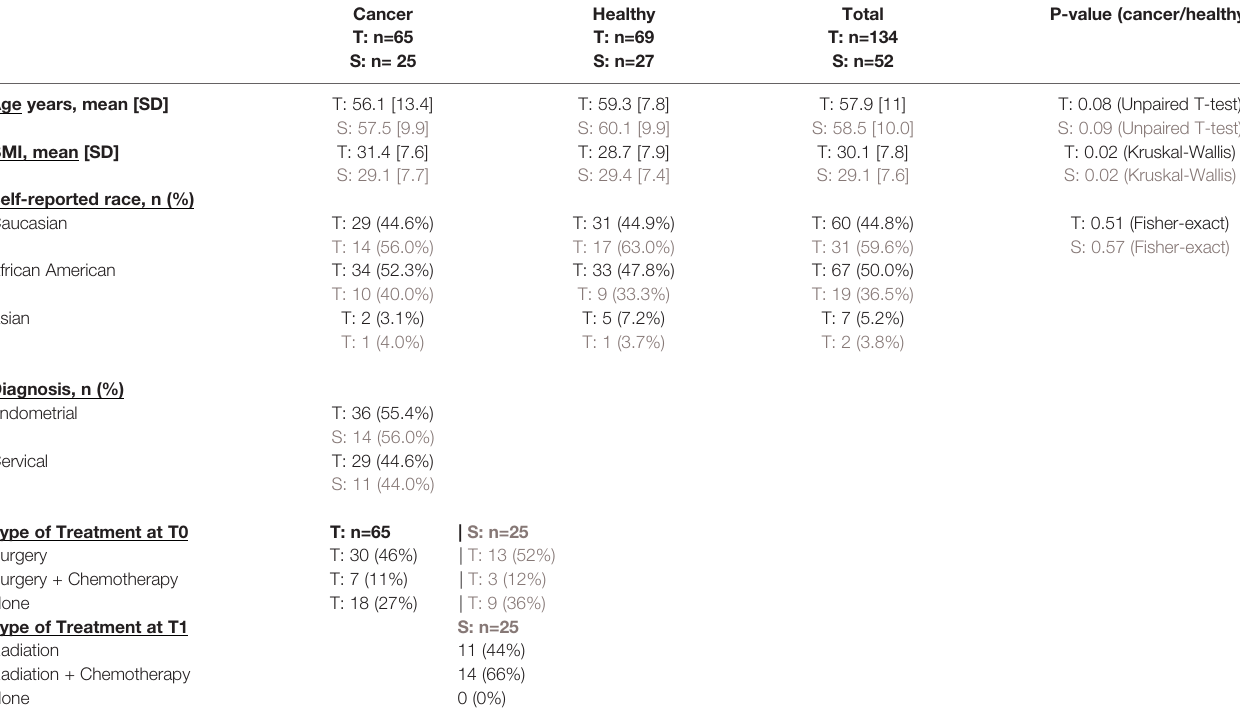
Tabledepictsallsubjectsincludedinthe study.Afterqualityassurance,a total ofsixdatasetswereexcludedduetolowquality,thus124subjectshadVMat T0.Forasubsetofthose subjects (n=52), longitudinal data were obtained (depicted in grey color). After excluding low quality datasets, 42 subjects (22 cancerand 20 healthy)had longitudinal VM data at four time points. Summary statistics are given for the total population recruited in the study and had baseline data analyzed (T) as well as for the subset of patients that had longitudinal data available (S).